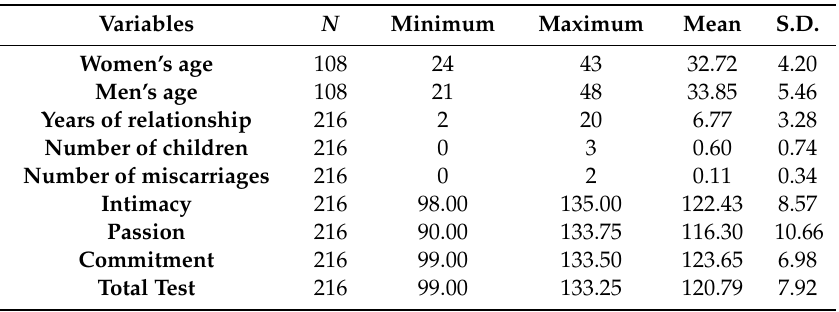
Table 1. Mean values of the quantitative variables studied.